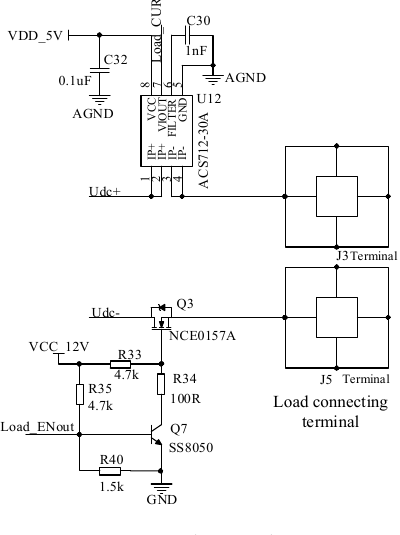
Figure 13. Load control circuit.